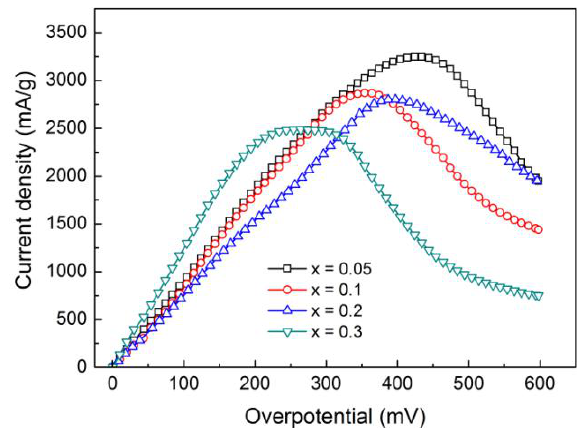
Figure 8. Anodic polarization curves of La